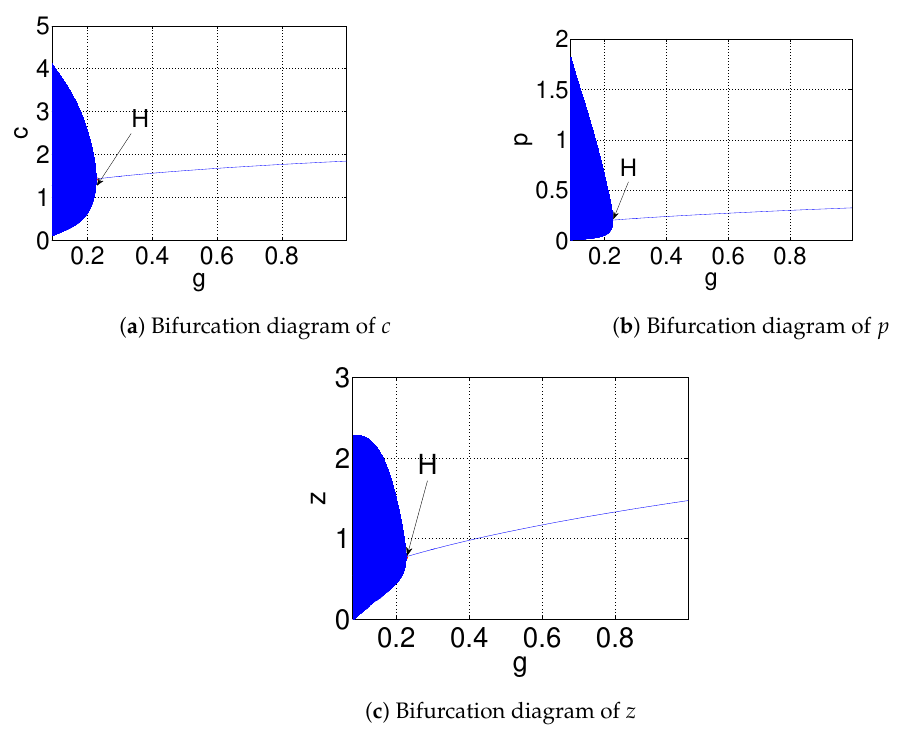
Figure 15. Bifurcation diagrams of system (1) while g varies from [ 0.09,1 ] and the others remain unchanged, as in Figure 6. Here, the interior equilibrium (cid:98) E ( (cid:98) c , (cid:98) p , (cid:98) z ) is unstable with a periodic solution when g ∈ [ 0.09, g [ H ] = 0.226067 ) and stable when g > g [ H ] = 0.226067.